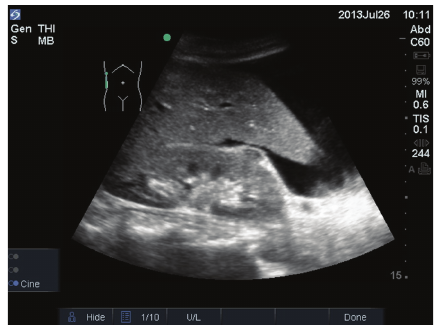
Figure 1: Free intra-abdominal fluid on